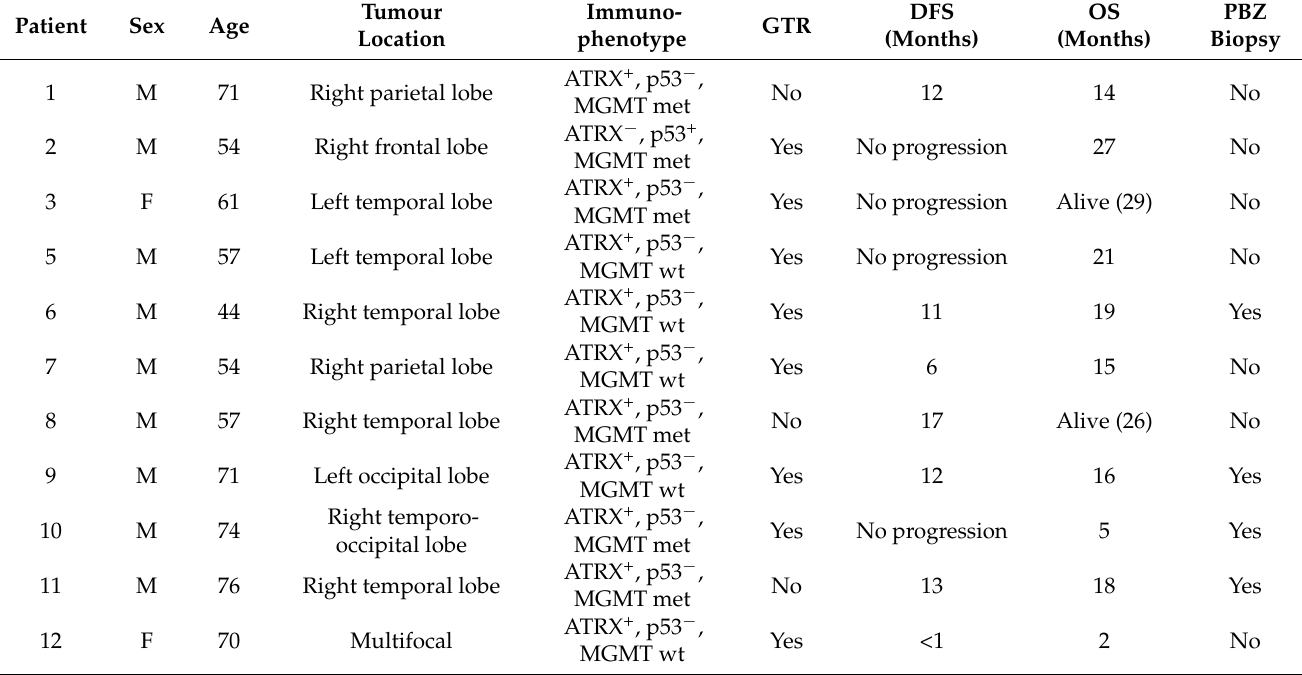
Table 1. Clinic–pathological characteristics, immuno-molecular phenotype, details on the type of surgery performed (gross total tumour resection—GTR), and disease monitoring and surveillance of patients enrolled in the study are reported. M: male; F: female; GBM: glioblastoma IDH-wildtype; + : >30% of positive cells; − : <30% of positive cells; met: methylated; wt: wildtype; DFS: disease-free survival; OS: overall survival; -: no information; PE: pulmonary